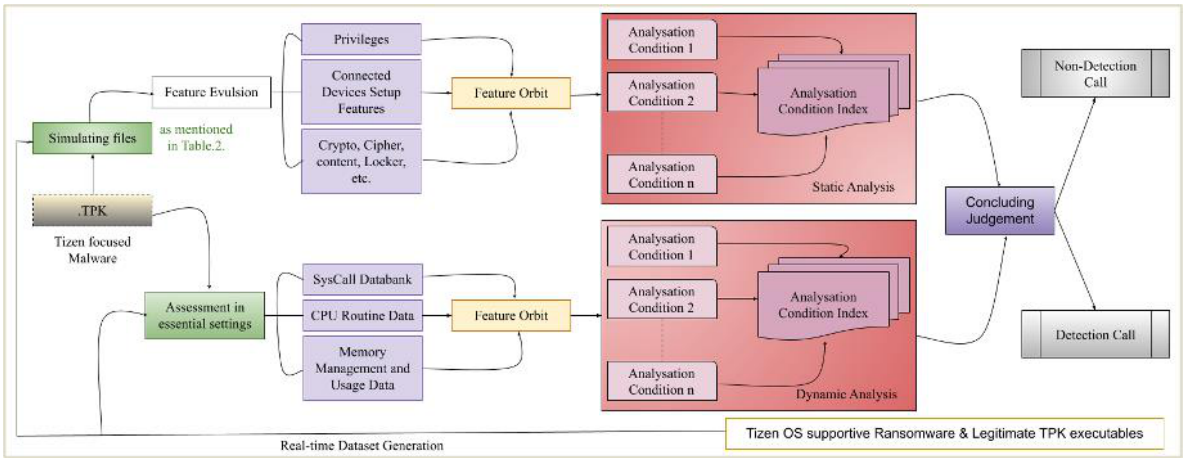
Figure 2. Ransomware analysis and identification architecture (i.e., before Denial-o-Service). The following factors are maintained constant during the entire